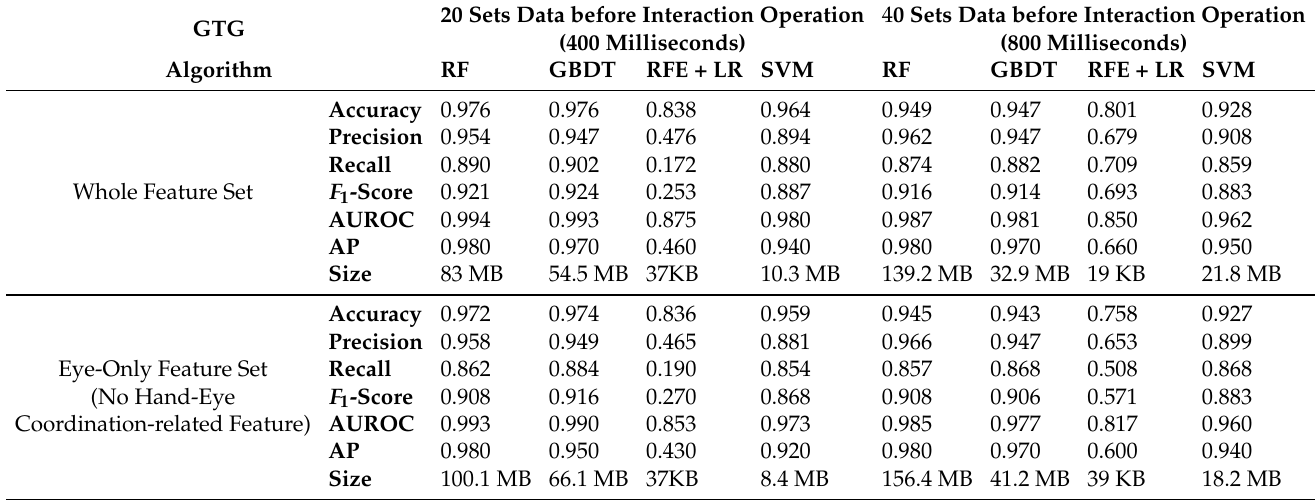
Table 3. Binary classification results for the combinations of four classifiers (RF, GBDT, LR, and SVM), two feature sets, and two GTG methods. 20 Sets Data before Interaction Operation 4 0 Sets Data before Interaction Operation (400 Milliseconds) (800